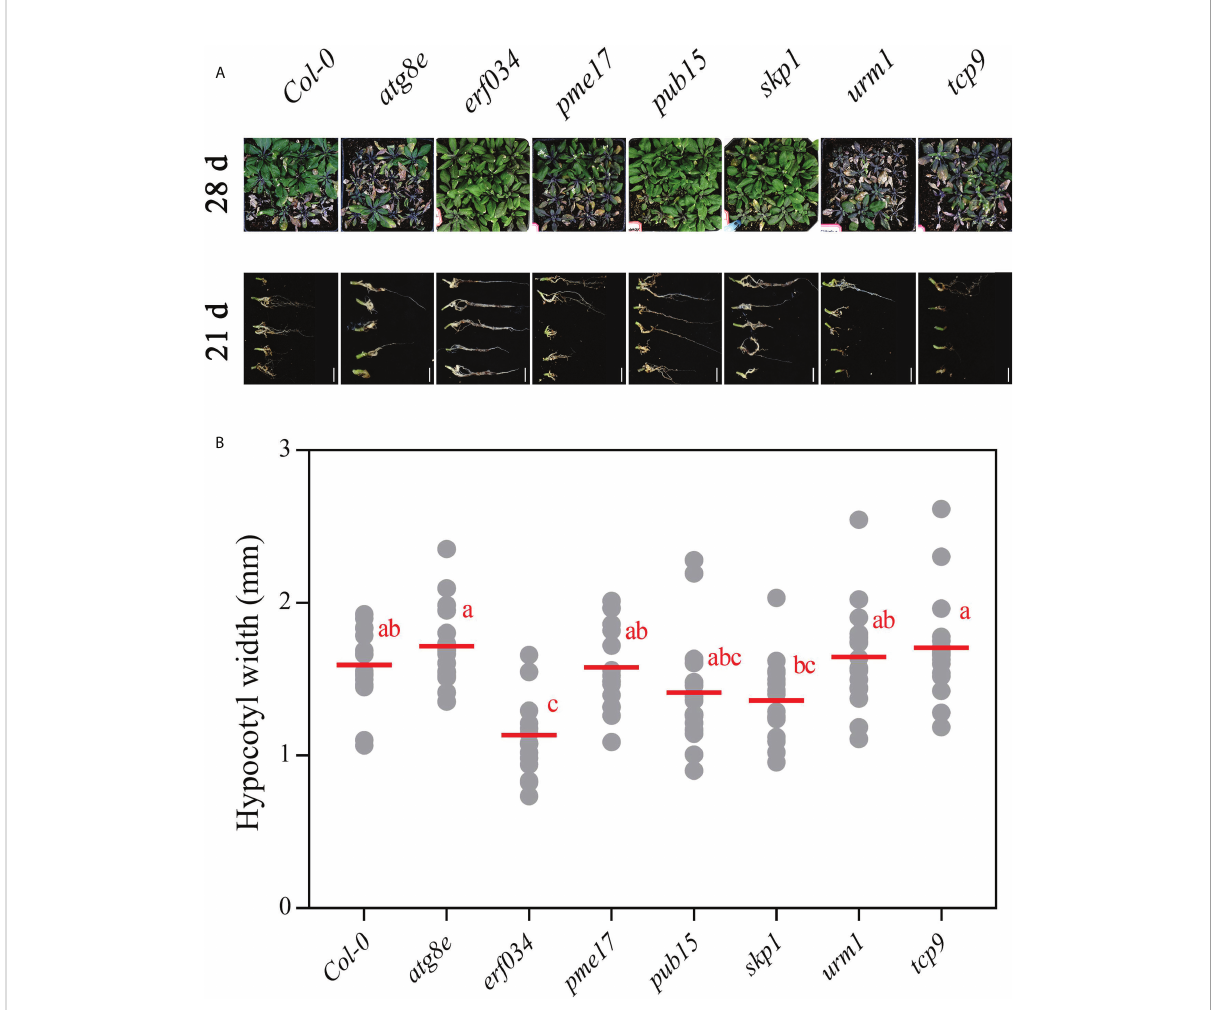
FIGURE 5 Phenotypes of A. thaliana inoculated with P. brassicae in soil culture. (A) Above-ground parts of Col-0 and each mutant material at 28 dpi, roots at 21 dpi; scale bars represent 2 cm. (B) Hypocotyl width of A. thaliana inoculated with P. brassicae at 21 dpi. Scatter plots present individual hypocotyl width measurements (12 replicates for each treatment), calculated means and SEs. Different letters indicate signi fi cant differences between means (Tamhane ’ s test, p <